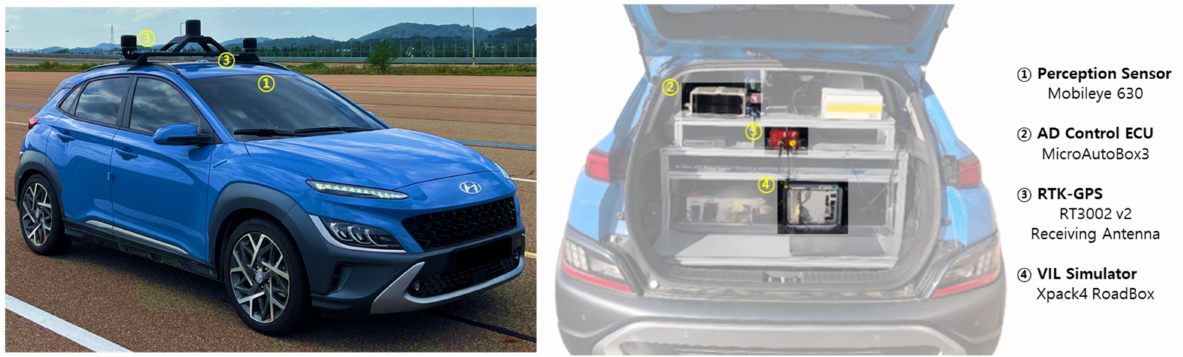
Figure 14. Hyundai Kona vehicle equipment